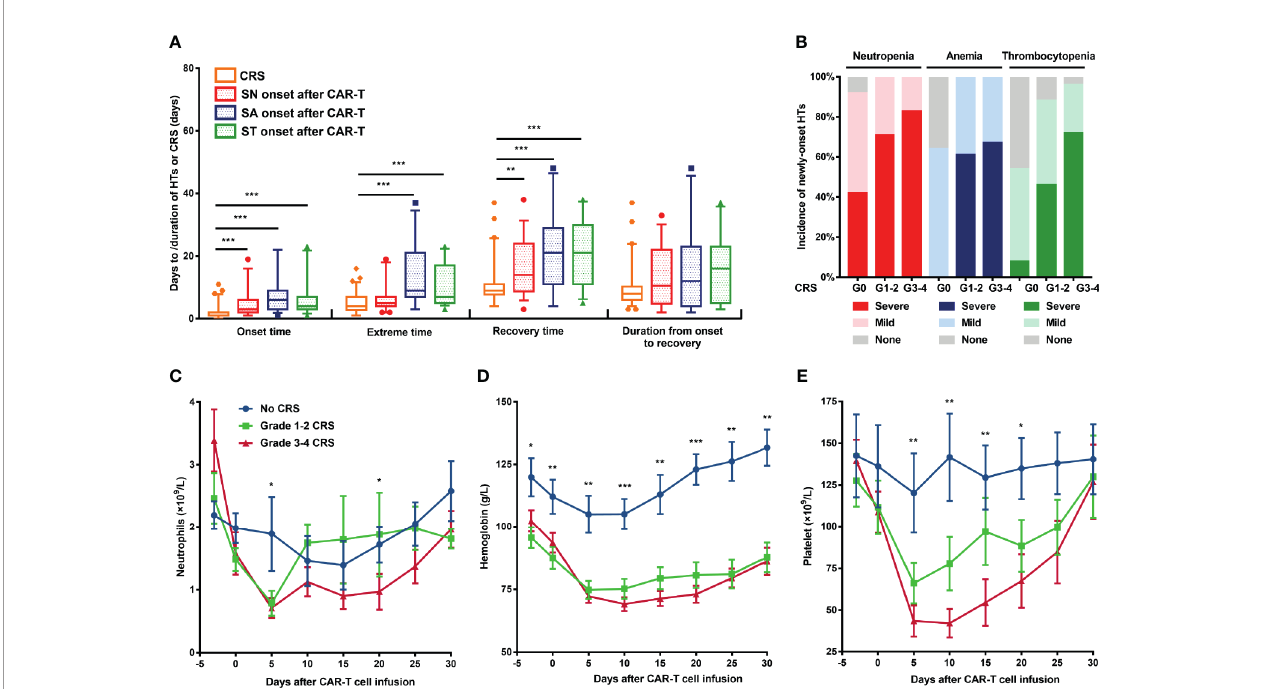
FIGURE 2 | New-onset severe hematological toxicities correlated with CRS. (A) Comparison of temporal characteristics between CRS and severe cytopenia. (B) Incidence of each cytopenia is shown in patients without CRS or mild or severe CRS. (C – E) Neutrophil count, hemoglobin concentration, and platelet count (means ± SEMs) are shown at the indicated time after CAR-T cell infusion in patients without CRS or with mild or severe CRS. P values were determined using the Mann-Whitney U test (for A ) or the Kruskal-Wallis test (for C – E ). ***P < 0.001, **P < 0.01, *P < 0.05. CRS, cytokine release syndrome; HT, hematological toxicity; SN, severe neutropenia; SA, severe anemia; ST, severe